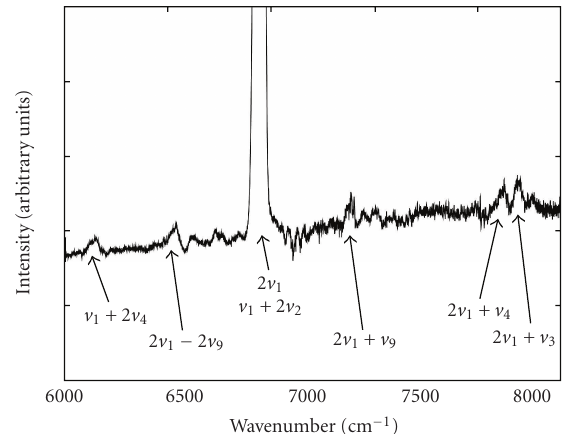
Figure 3: Illustration of combination bands observed for HNO 3 in the NIR. Assignments taken from Feierabend et al. [128,